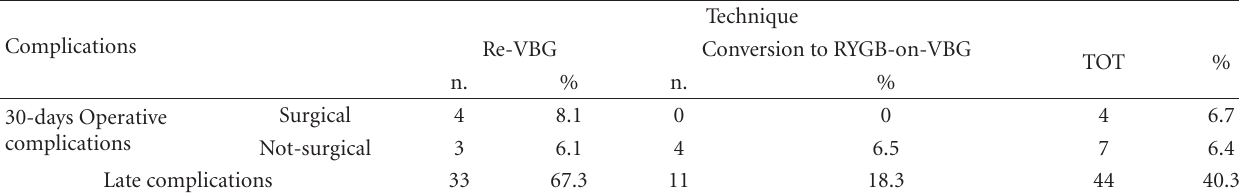
Table 3: Revisionary surgery for failed or complicated VBGs: 30-day operative and late complication rate.